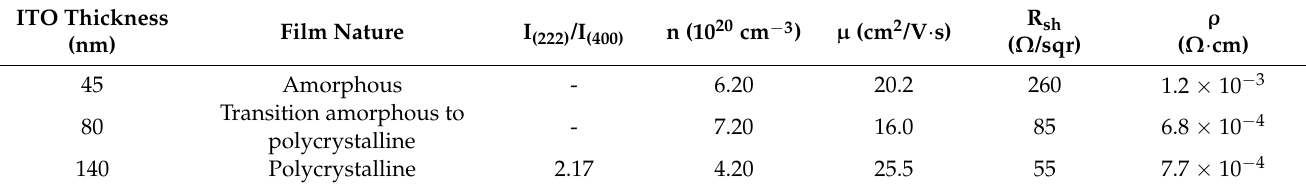
Table 1. Electrical parameters of the ITO films deposited at RT, 25 W and 0.17 Pa on resistive FZ silicon wafers. The nature of the film is also included. ITO